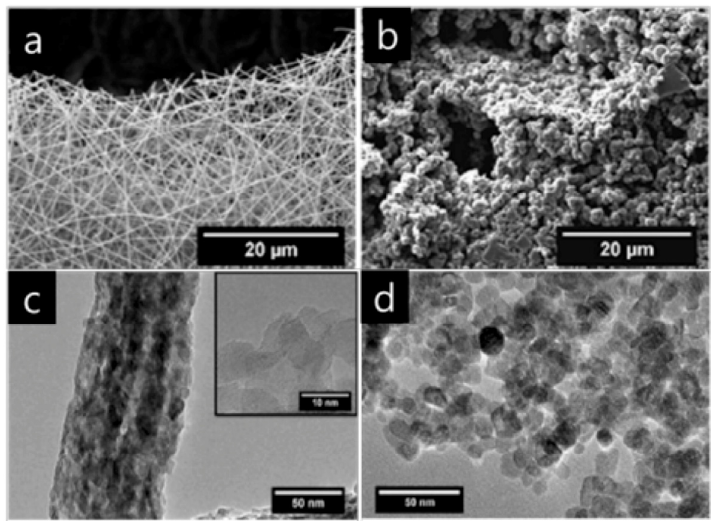
Figure 8. The SEM images of ( a ) TiO 2 fibers, ( b ) TiO 2 prepared using sol-gel method and TEM images of ( c ) TiO 2 fibers, and ( d ) TiO 2 prepared using sol-gel method, reprinted with permission from of (c) TiO 2 fibers, and (d) TiO 2 prepared using sol ‐ gel method, reprinted with permission from [103].